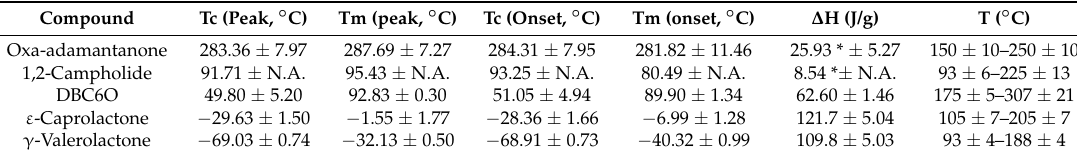
Table 2. Summary of thermal properties registered for both the commercial and the synthesized lactones presented in this study. The values and the errors reported are calculated based on the averages and standard deviations respectively registered in all six measurements and three repetitions. A wide range of temperatures was observed, however high degrees of supercooling and low enthalpies of fusion below 120 J/g marked the lactones’ unsuitability as PCM. 1,2-Campholide showed inconsistent crystallization, with several cycles lacking any clear crystallization peak. As such, the errors could not be derived and are here reported as N.A (non-applicable). Given that oxa-adamantanone and 1,2-campholide’s phase change occurs within the same range of their thermal decomposition, the values of average enthalpy calculated have been starred to signal a potentially inaccurate and inconclusive